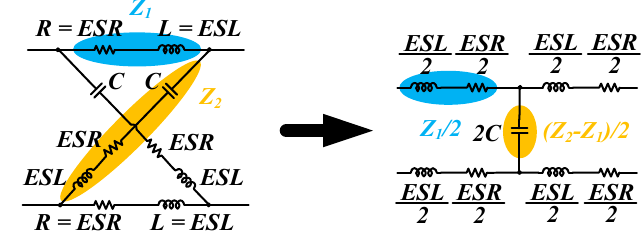
Figure 4. The equivalent series inductance ( ESL ) and equivalent series resistance ( ESR ) elimination concept for capacitors [3]. Z 1 = compensation impedance. Z 2 = non-ideal capacitor equivalent circuit.